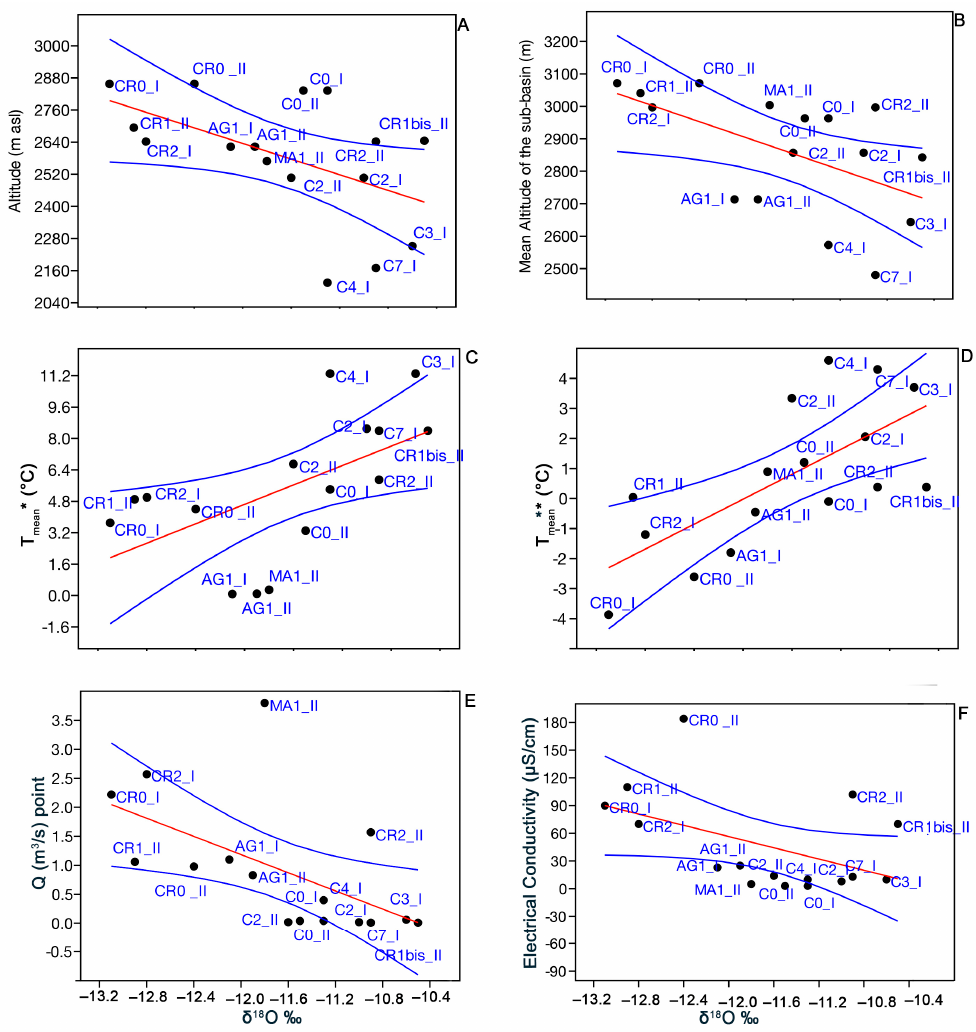
Figure 5. ( A ) δ 18 O vs. sampling altitude and ( B ) δ 18 O vs. mean altitude of the sub-basin; ( C ) δ 18 O vs. water T mean * measured for three weeks before sampling δ 18 O and ( D ) δ 18 O vs. air T mean** measured from January to the sampling period; ( E ) δ 18 O vs. discharge and ( F ) δ 18 O vs. electrical conductivity.